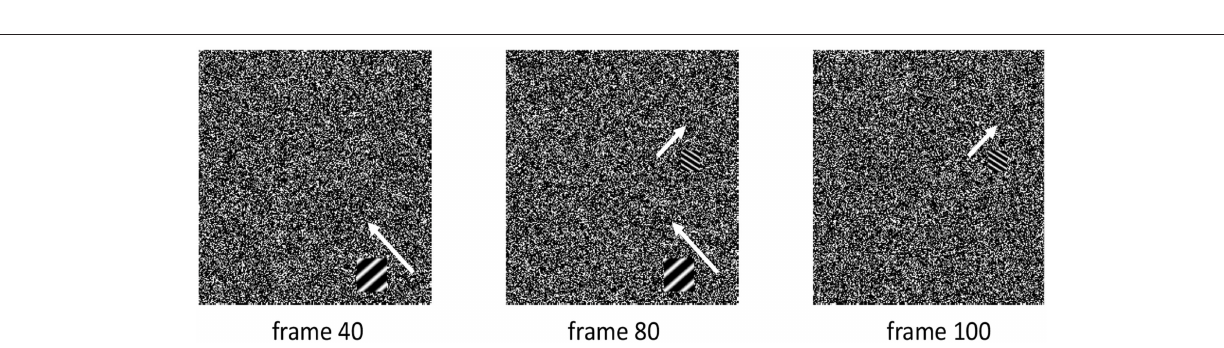
FIGURE 7 | Simulation characterized by a sequence of random images with two different 2D sinusoidal waves of limited time duration, appearing in two different regions of the random images. The two sinusoidal waves are simultaneously present over 20 frames, and they have different direction of propagation (indicated by the white arrows), different frequency, and different speed of propagation (with the smaller wave having a higher speed than the larger